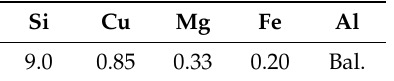
Table 1. Chemical composition of the AlSi9CuMg aluminum alloy